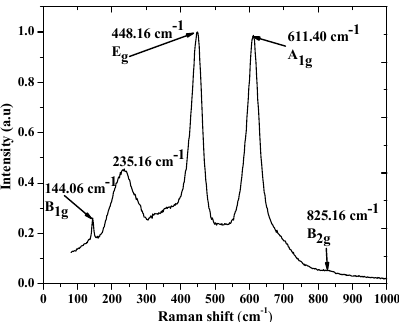
Figure 7. Raman spectrum of the obtained rutile TiO 2 NPs.